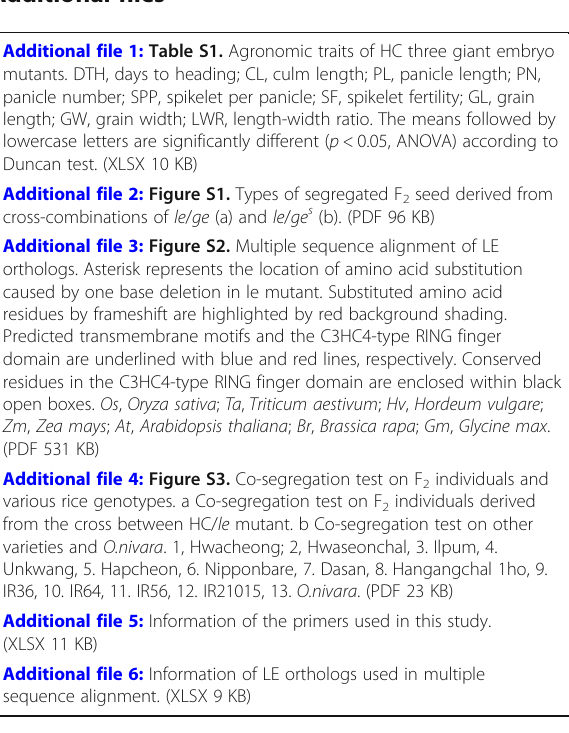
file 1: Table S2. Additional file 2: Table S3,